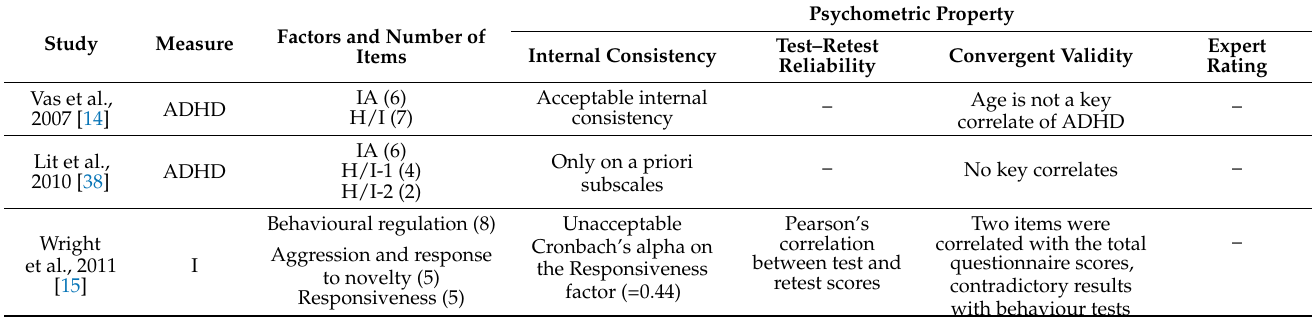
Table 1. Summary of obtained factor structure and assessed psychometric properties of the Dog ARS across